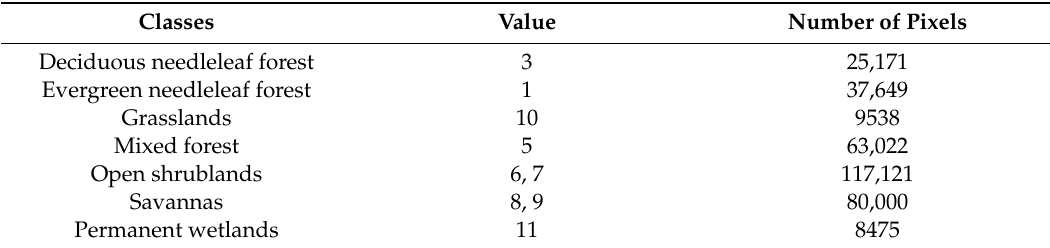
Table A2. Harmonized legend used and correspondence with the original product classes.